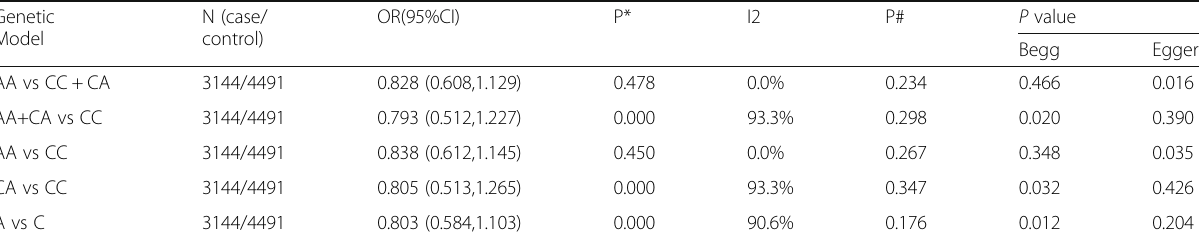
Table 5 Meta-analysis of TNF- α 863C/A polymorphisms and CAD susceptibility Genetic